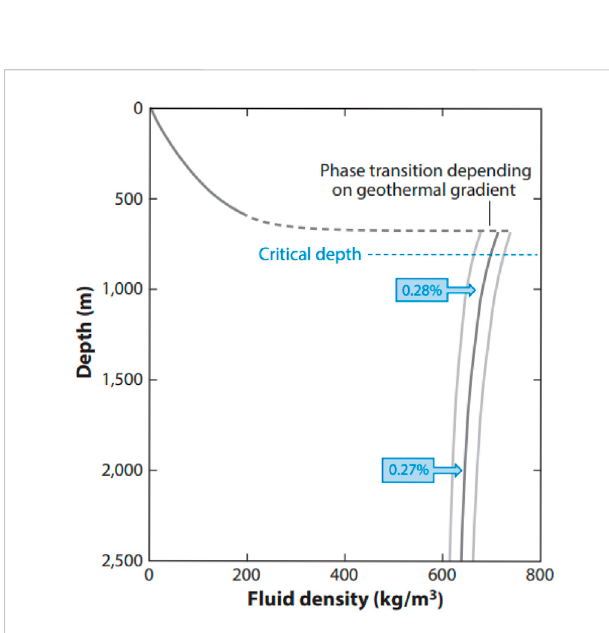
FIGURE 7 CO 2 density versus depth for a geothermal gradient of 35 ° C/km (± 2 ° C/km; gray lines) and hydrostatic pore pressure. CO 2 transitions from gastoasupercritical fl uidbetween550 mand750depths,dependingon temperature. Blue boxes show the relative volume of CO 2 at depth compared to surface volumes (Ringrose et al., 2021).